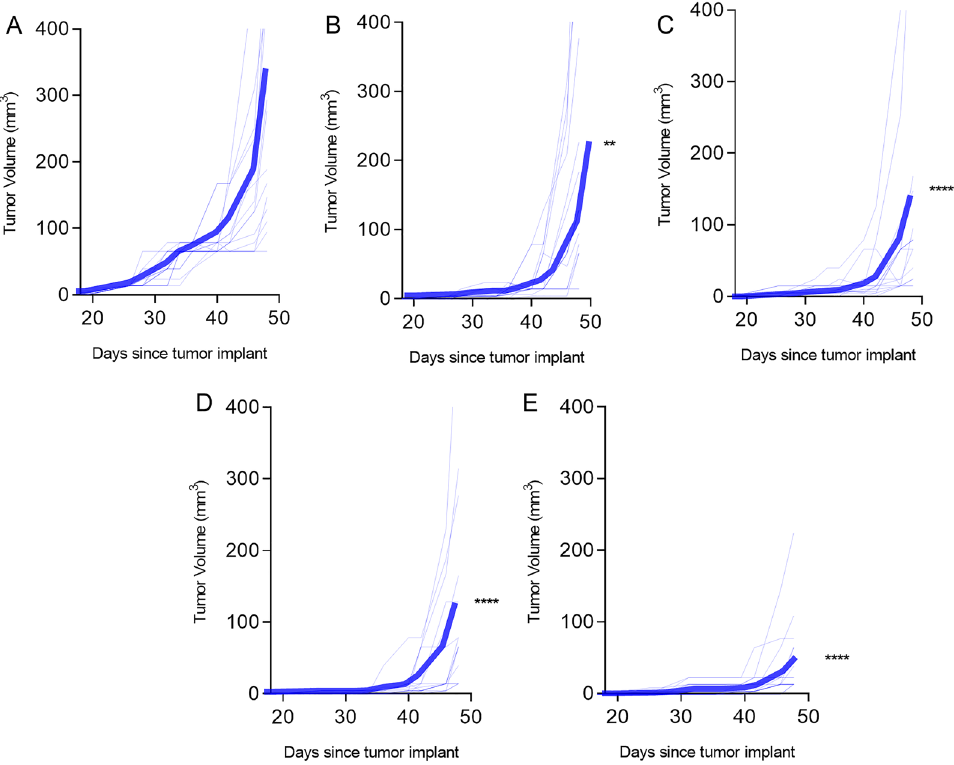
Figure 3. A Th1 selective multiantigen vaccine, administered prior to tumor implant, is effective in inhibiting prostate cancer growth. Tumor volume (mm 3 ) from mice vaccinated with ( A ) adjuvant alone or the peptide pools derived from ( B ) AMACR, ( C ) PSMA, ( D ) HPN or ( E ) a combination of the epitopes (multiantigen vaccine). Volume for individual mice (n = 15/group) is presented in thin lines and the mean volume is presented as the thick line. **p < 0.01; ****p <